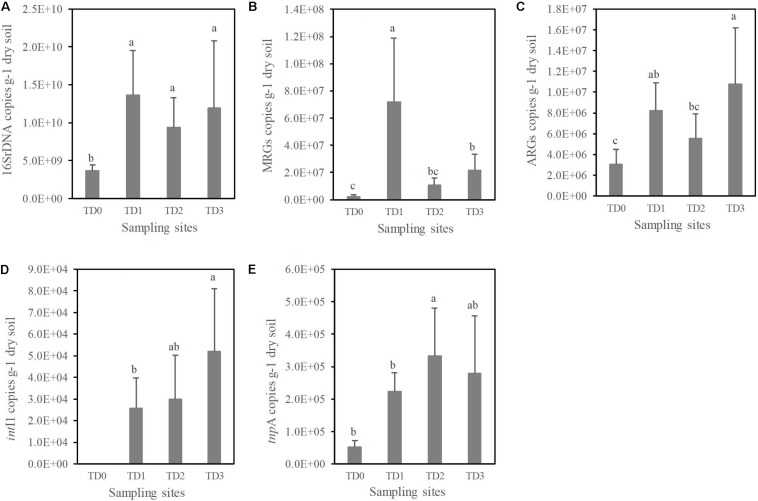
The abundances of 16S rDNA (A), total detected metal resistance genes (MRGs) (B), total detected antibiotic resistance genes (ARGs) (C) and mobile gene elements (intI1 and tnpA) (D,E) at each sampling site. TD0 site is on the tailing dam and covered with annual herbs. TD1 site with about 15 years of poplar plantation is at the bottom of the dam. TD2 site is farmland and adjacent to TD1 site. TD3 site with about 10 years of poplar plantation is the farthest away from the dam. Columns show the means of replicates within the sampling sites, and vertical bars show standard error. Different letters indicate that the means are significantly different among sampling sites with Duncan test (P < 0.05).